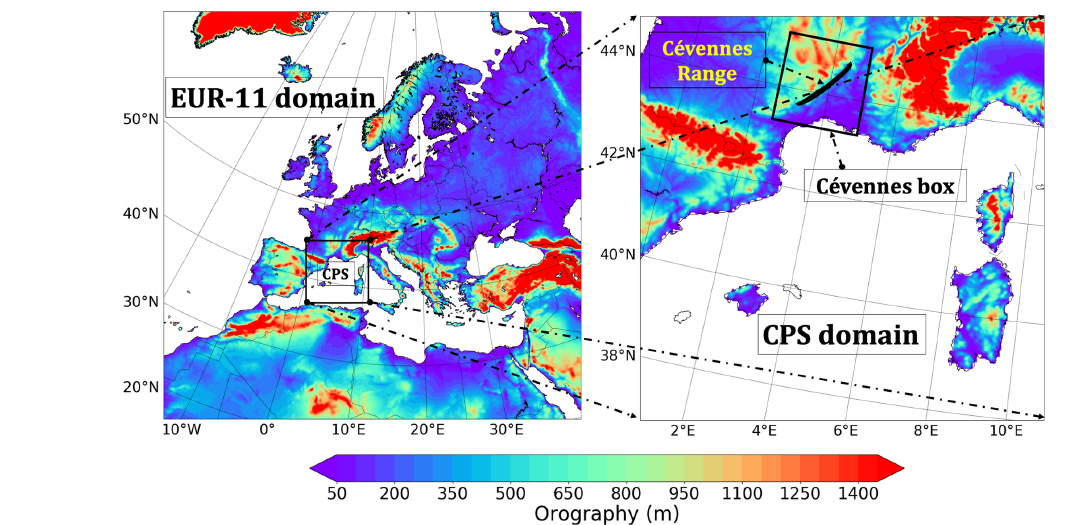
Figure 1. The domains of EURO-CORDEX and convection-permitting simulations. The shading colours denote the surface height above mean sea level from